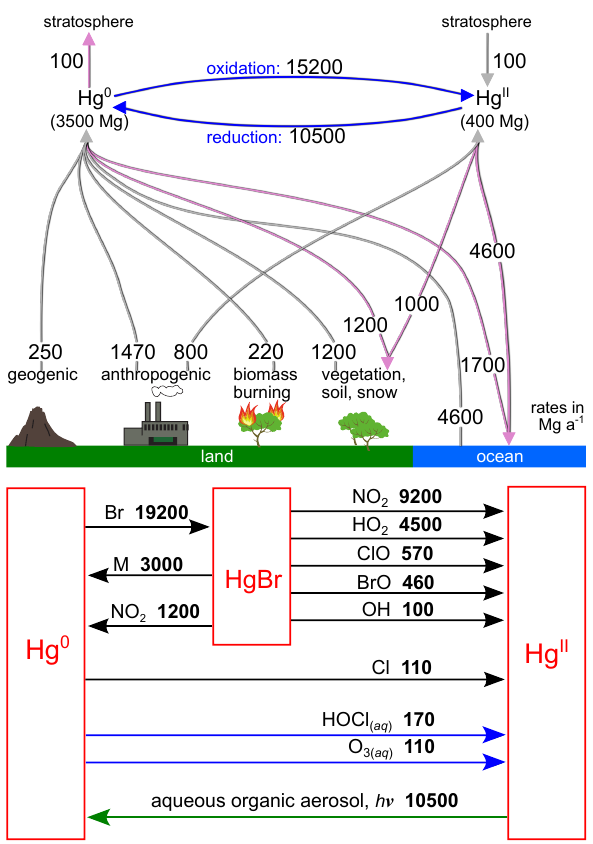
Figure 2. Global budget of tropospheric mercury in GEOS-Chem. Hg II includes gaseous and particulate forms in local thermodynamic equilibrium (Amos et al., 2012). The bottom panel identifies the major chemical reactions from Table 1 cycling Hg 0 and Hg II . Re- actions with global rates lower than 100Mgyr − 1 are not